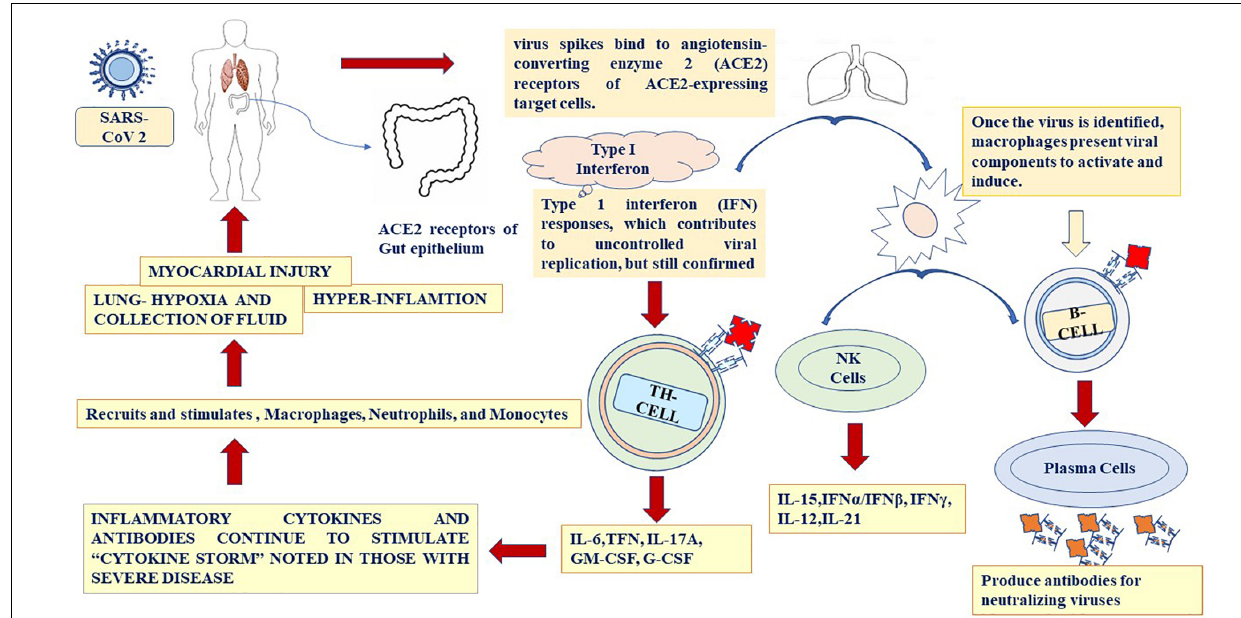
FIGURE 4 | Immune response during SARS-CoV-2 infection.